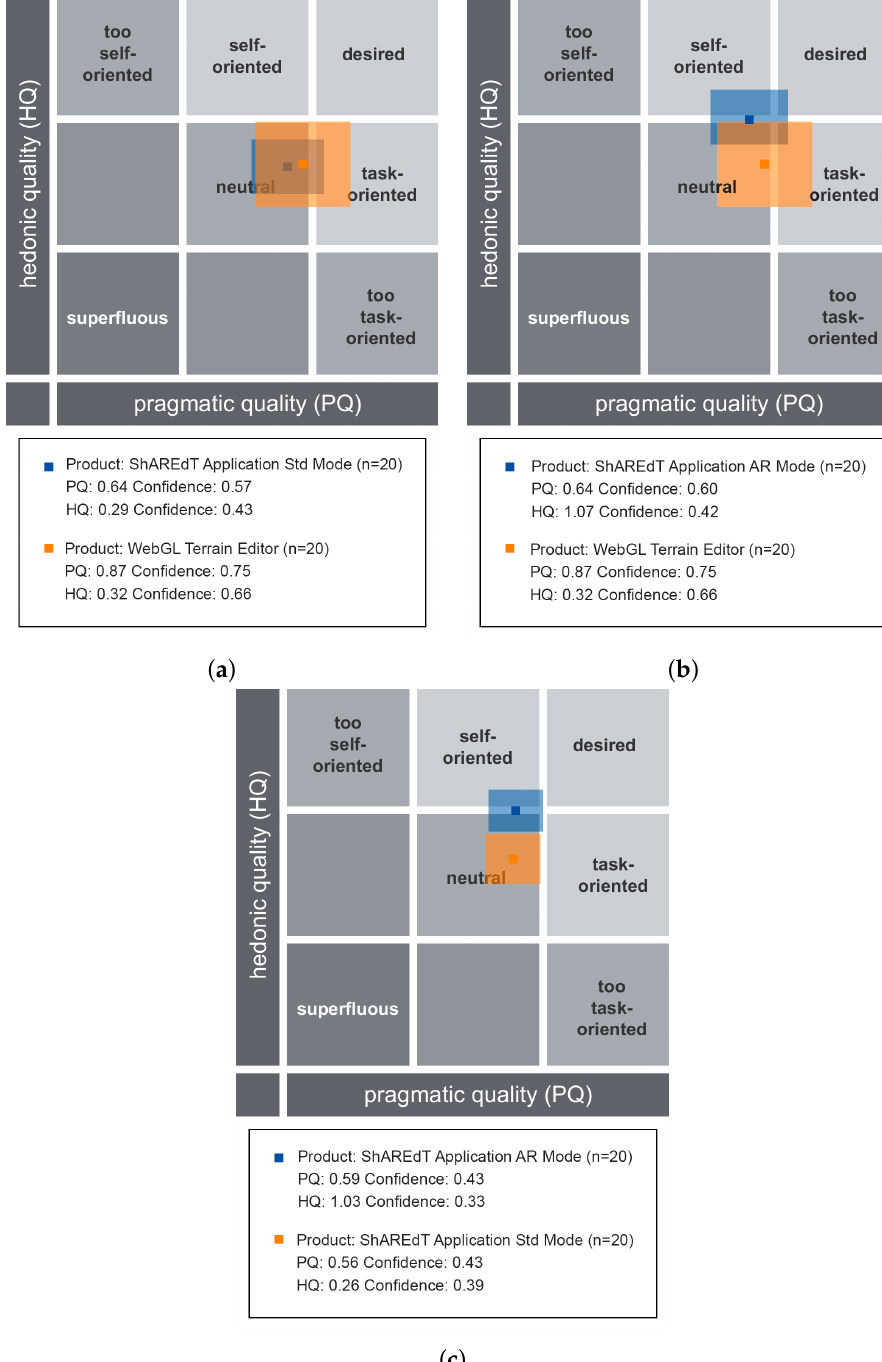
Figure 11. AttrakDiff porfolio charts for the three comparisons. ( a ) ShAREdT in standard mode vs. WebGL; ( b ) ShAREdT in AR mode vs. WebGL; ( c ) Standard mode vs. AR mode of